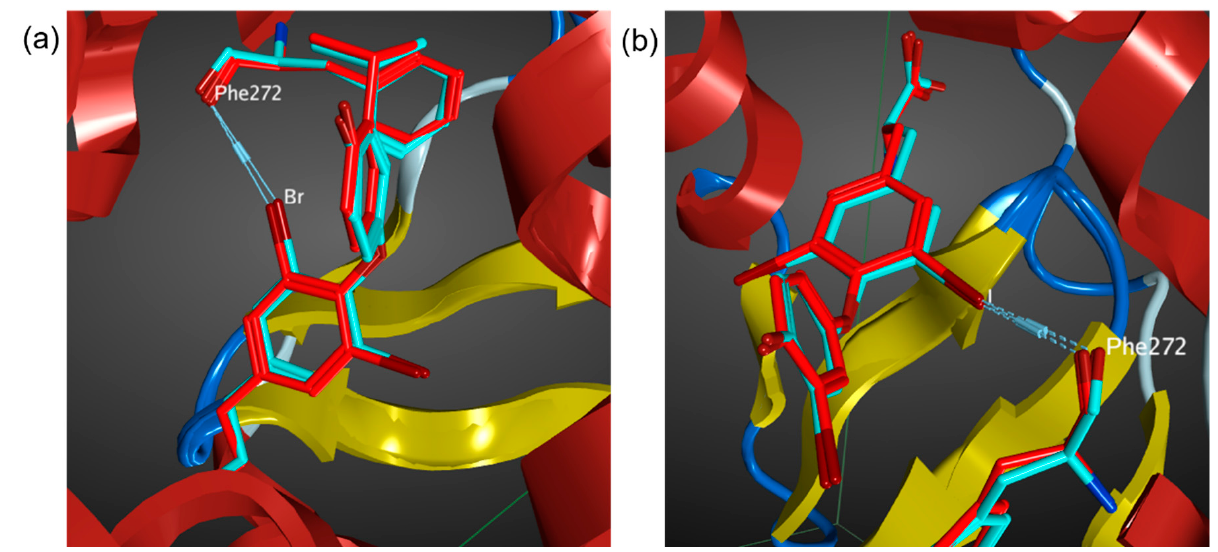
Figure 2. ( a ) Superimpose of MD predicted binding pose (blue) with crystal structure 2J4A (red). ( b ) Superimpose of MD predicted binding pose (blue) with crystal structure 1XZX (Red).